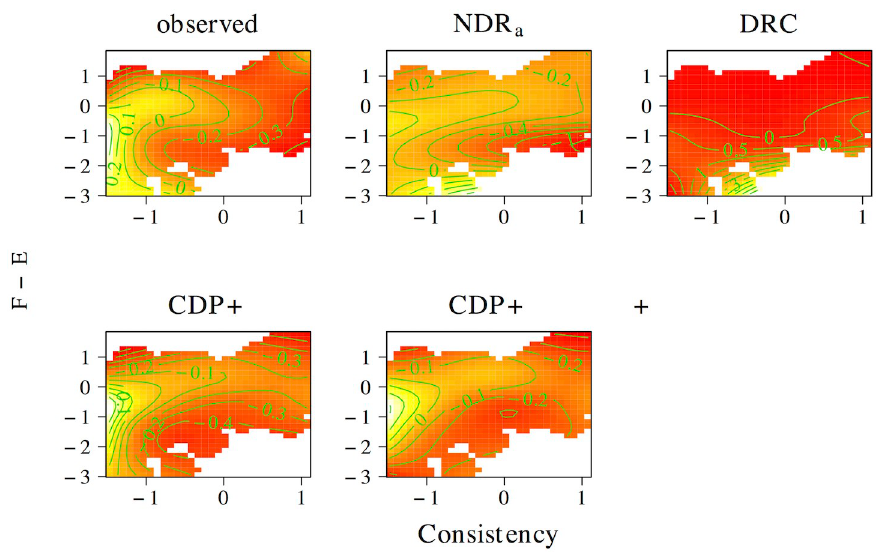
Fig 14. Interplay of consistency and friends minus enemies. The interaction of consistency with friends minus enemies in tensor product GAMs.